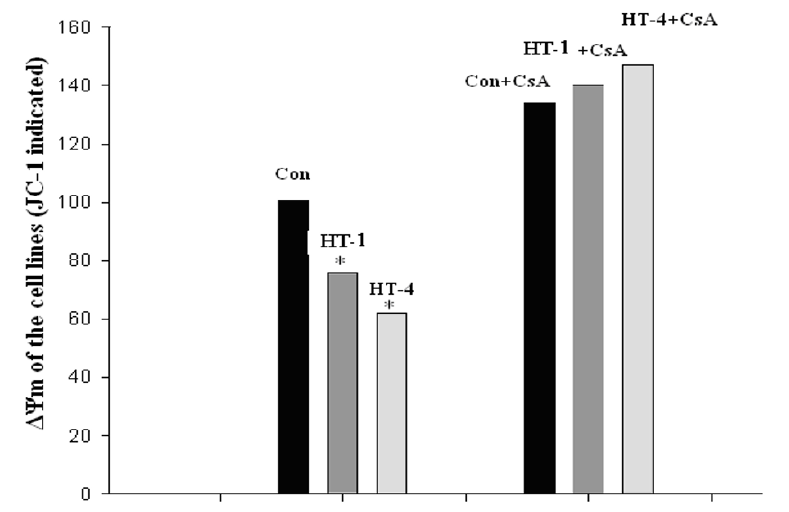
Figure 5 Comparison of ΔΨ of cell lines from patients and controls . The average ΔΨ m ing the tRNA Ile A4263G mutation was decreased by 32% compared to control cell lines. ΔΨ controls and patients were improved by CsA; control values increased by 33.6%, III-14 values increased by 84.4%, and III-19 values increased by 137.7%.